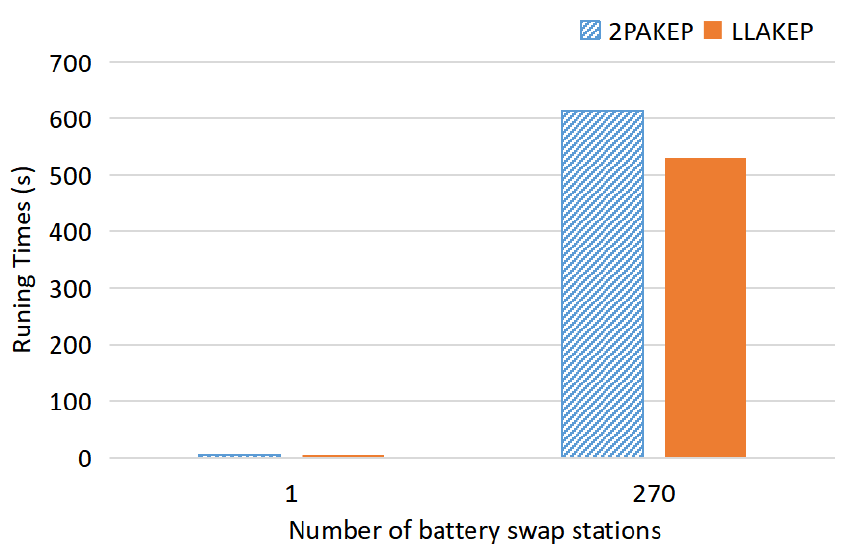
Figure 9. Runing time in Experiment IV. The experiment tests the total running time of all the batteries of 270 battery swap stations in the authentication phase. The results show that the total running time of LLAKEP is significantly less than